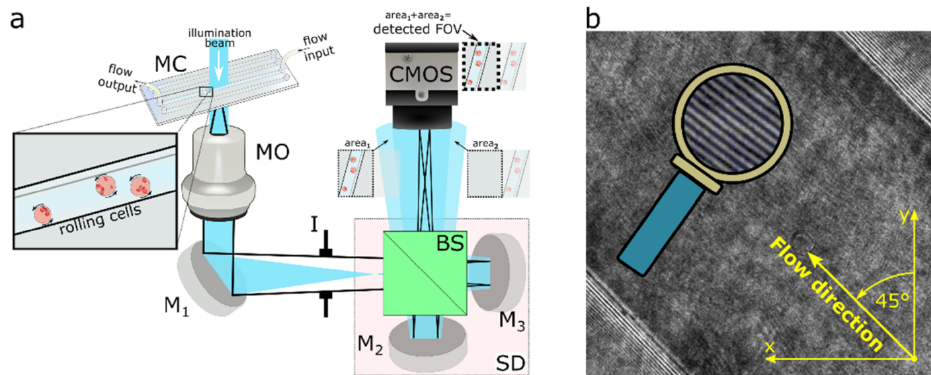
Figure 1. ( a ) Sketch of experimental arrangement. MO—microscope objective; MC—microfluidic chip; Ms—mirrors; I—iris diaphragm; BS—beam splitter; CMOS—camera; SD—shearing device. The image in front of the MO provides a zoom into the MC with cells rolling on the channel-side wall. Inserts in front of the CMOS illustrate replicas arising from the SD. The highlighted image portions (area 1 and area 2 ) represent overlapping areas detected by the CMOS, providing correct holographic performance. ( b ) Interference snapshot with a cell flowing inside the diagonally oriented (45 degrees) microfluidic channel. The zoom of the interference fringes is reported as inset within the draw of the magnifying